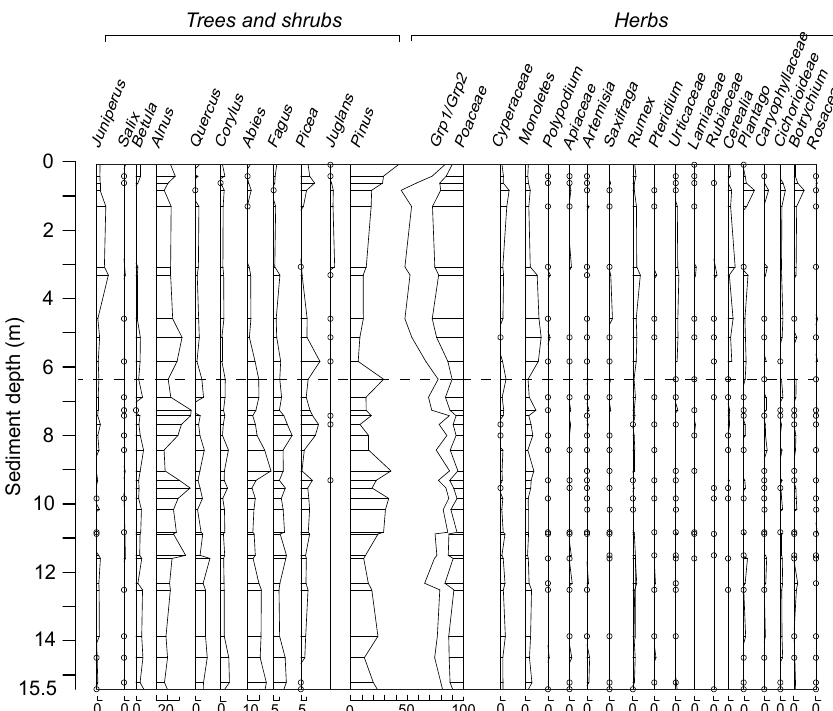
Figure 5. Simplified pollen of LAU11 sediment sequence in function of depth as a percentage of the pollen sum. Dashed line refers to depth of 6.35m. Dots refer to values below 1% of the pollen